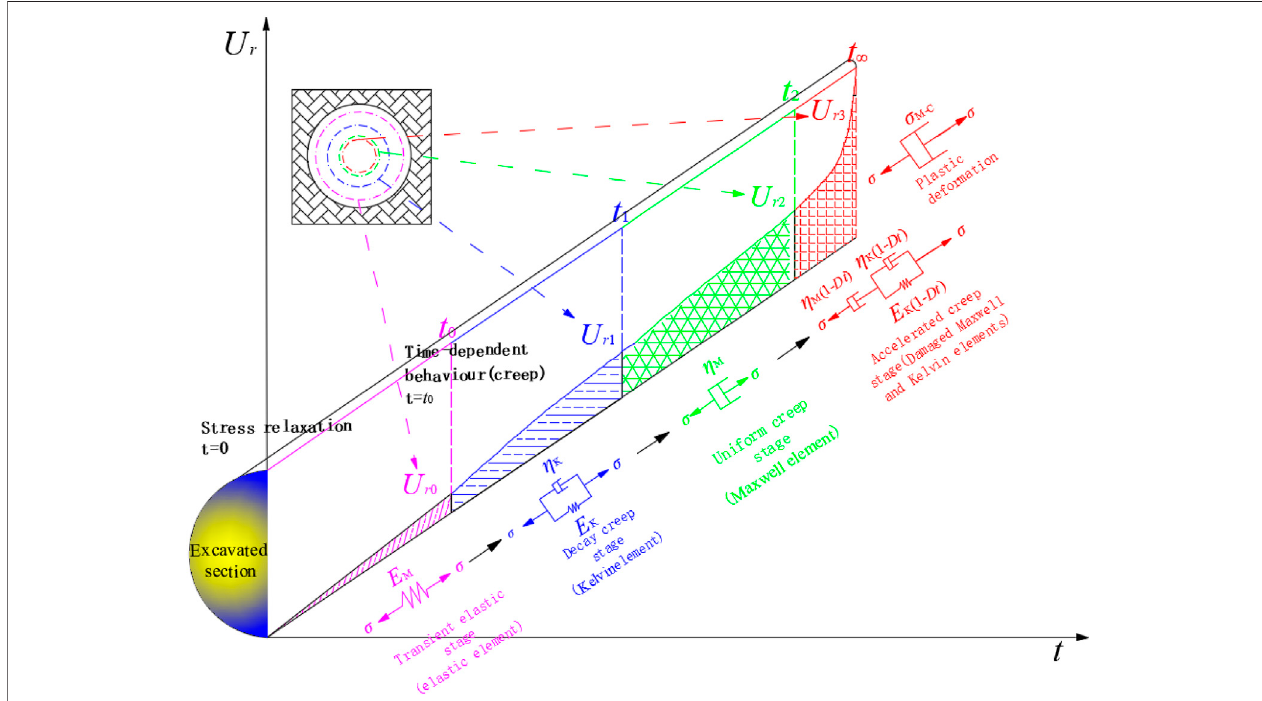
FIGURE 3 | Displacement-time relations of surrounding rocks.